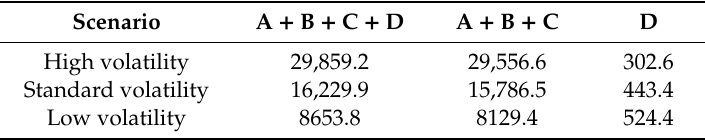
Table 2. Economic values of renewable energy R&D (Unit: Billion